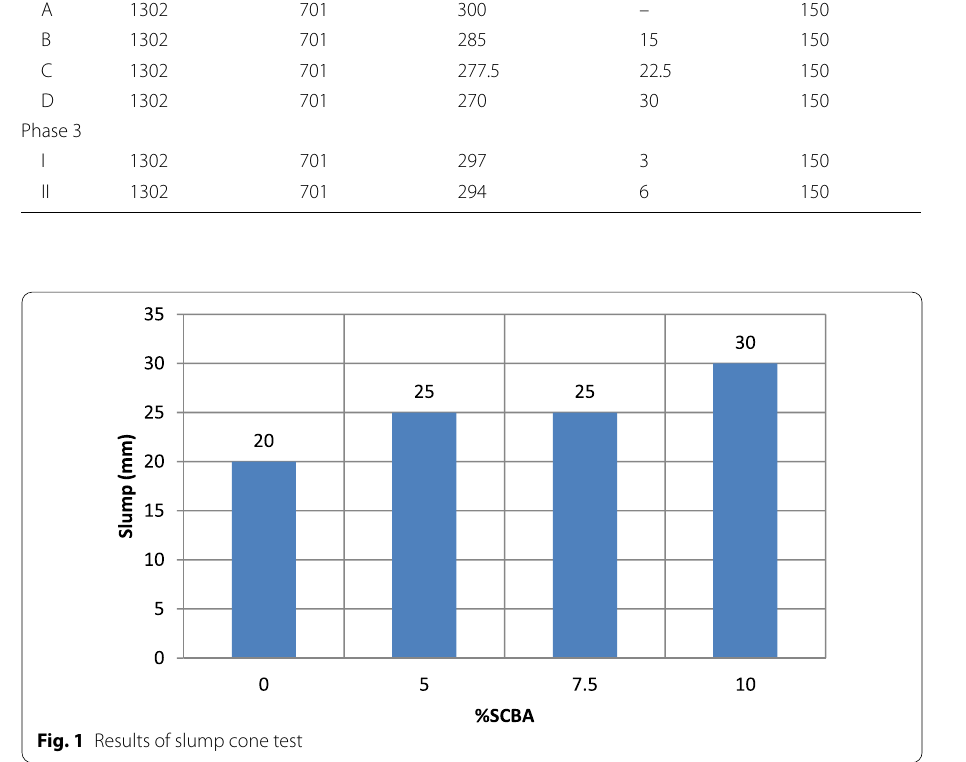
Fig. 1 Results of slump cone